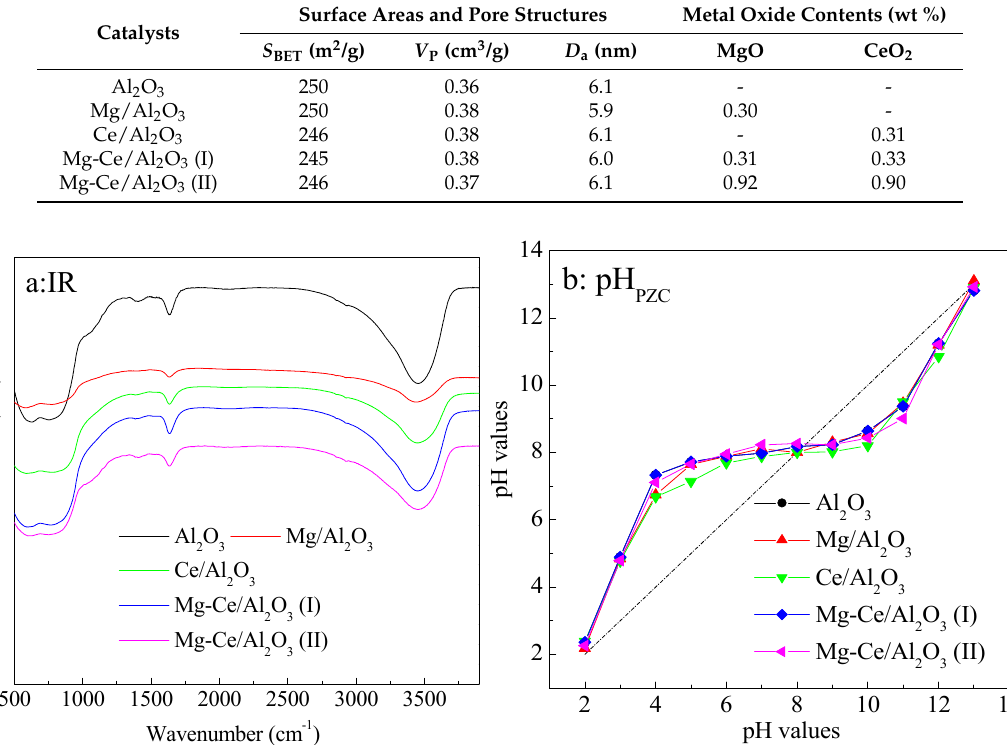
Figure 4. Infrared (IR) spectra ( a ) and pH pzc values ( b ) of Al 2 O 3 and metal oxide ‐ loaded Al 2 O 3 catalysts.